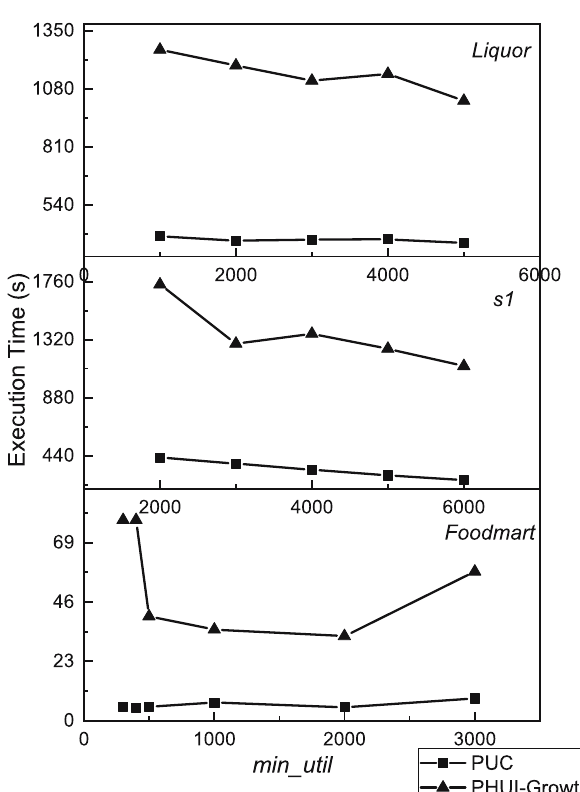
Figure 6: Comparison of PUC variants with PHUI -